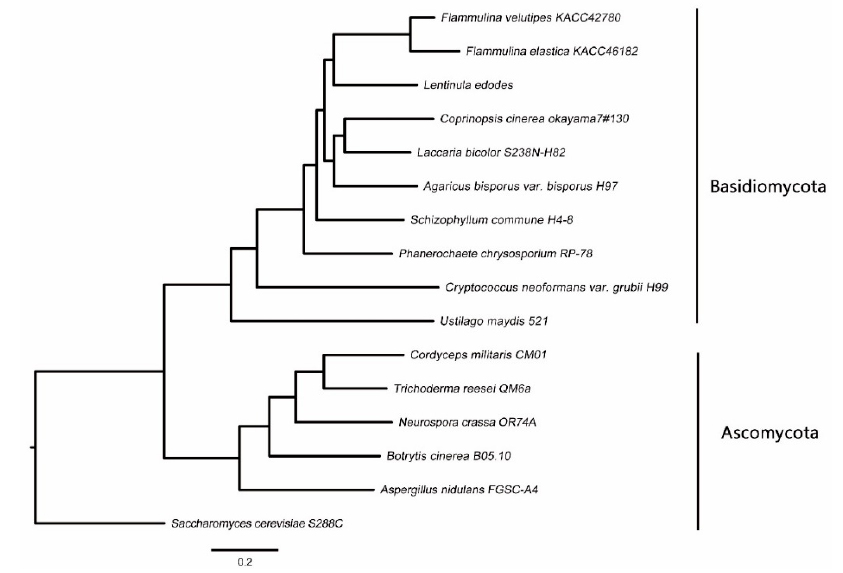
Figure 2. Phylogenetic tree of fungal species based on ortholog clustering.